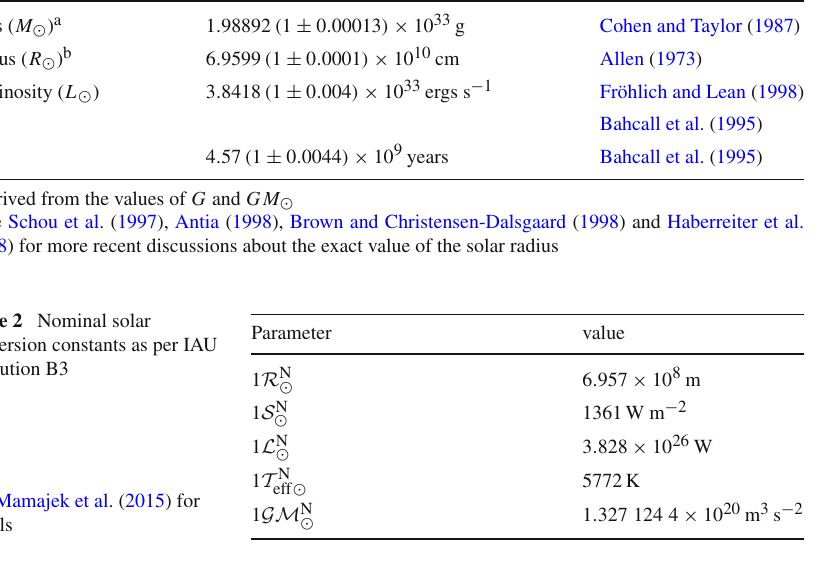
Table 1 Global parameters of the Sun Quantity Estimate